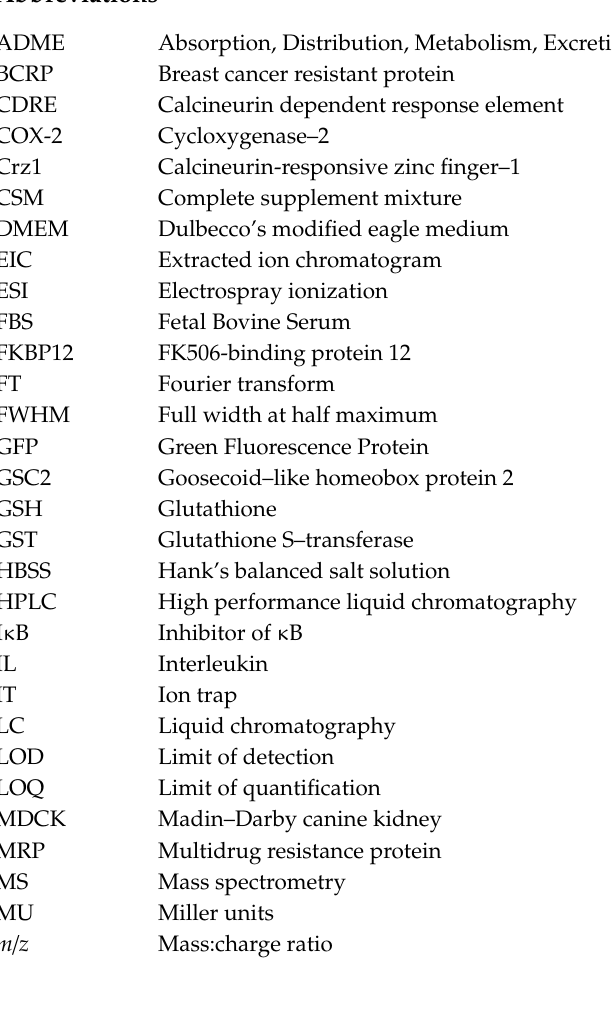
Figure S2: LC-MS analysis of parthenolide uptake from 0 h to 4 h in the apical side, Figure S3: LC-MS analysis of lactucin uptake from 0 h to 4 h in the apical side, Figure S4: LC-MS analysis of lactucopicrin uptake from 0 h to 4 h in the apical